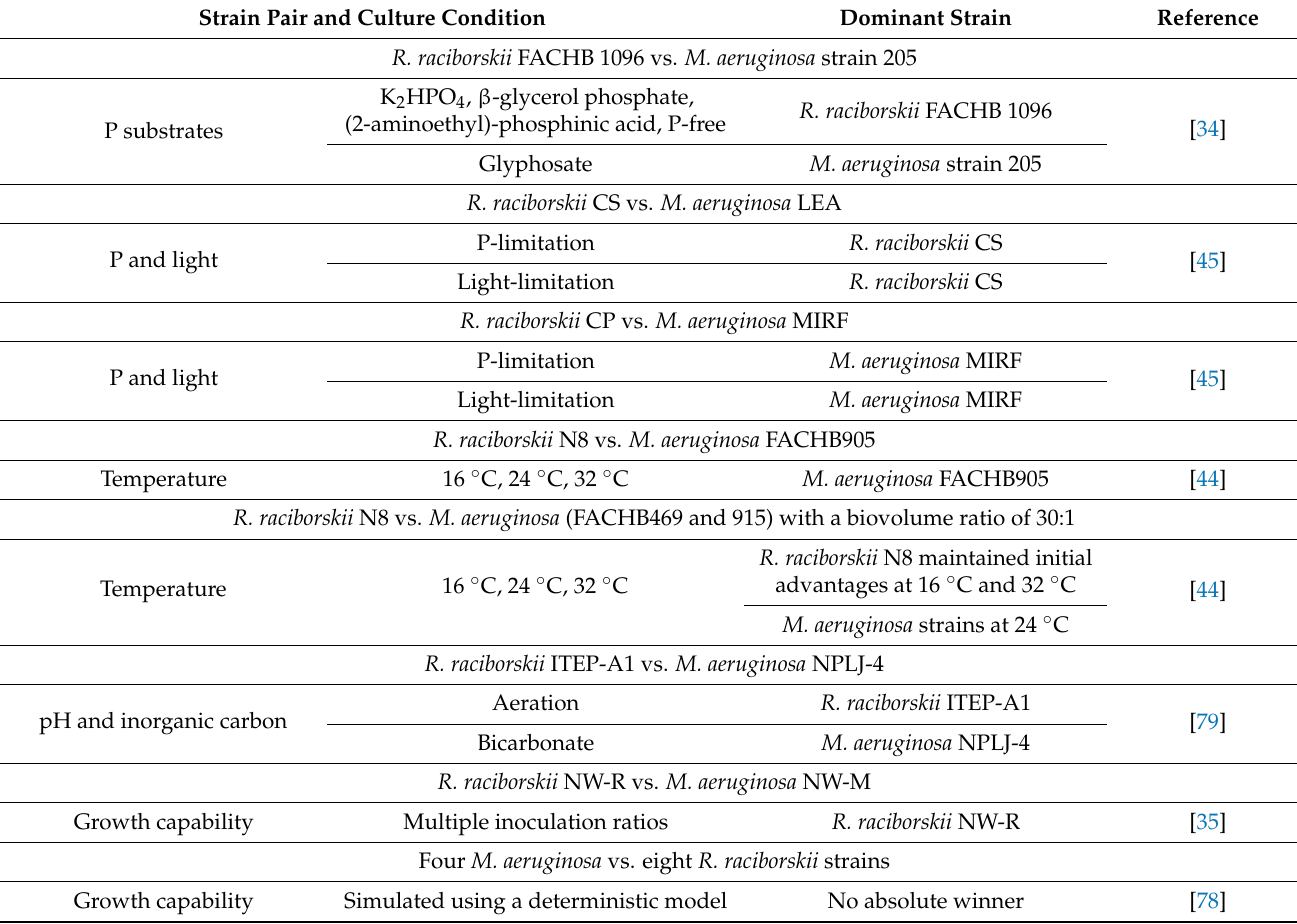
Table 2. Results of competition experiments using R. raciborskii and M. aeruginosa